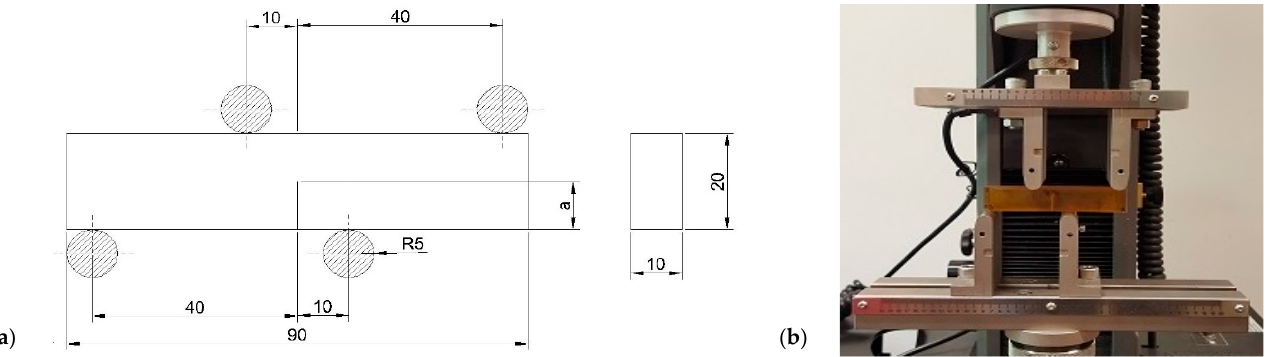
Figure 3. ( a ) Dimensions of the fracture toughness test sample (in mm). ( b ) Fracture toughness tests performed on the testing machine, 4 ‐ point bending test.